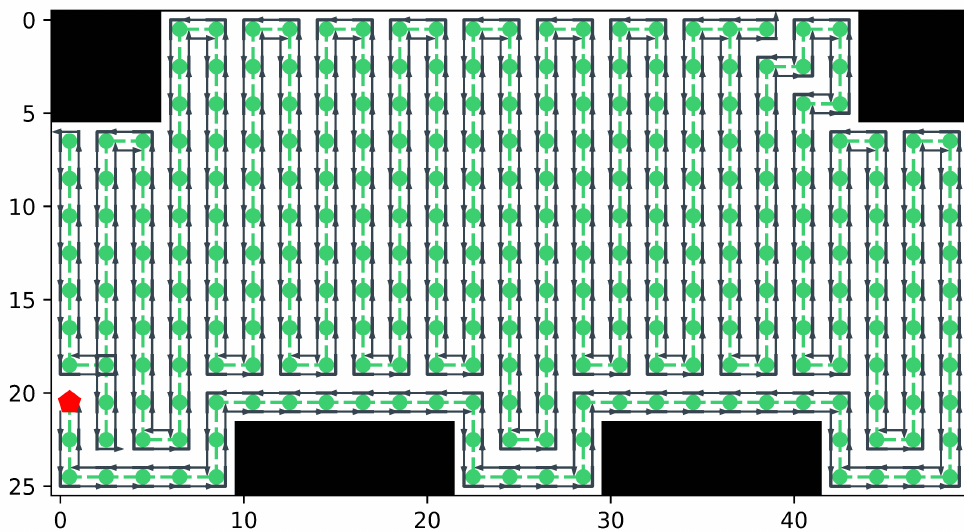
Figure 5. Complete coverage path planning using spiral STC algorithm in a predefined